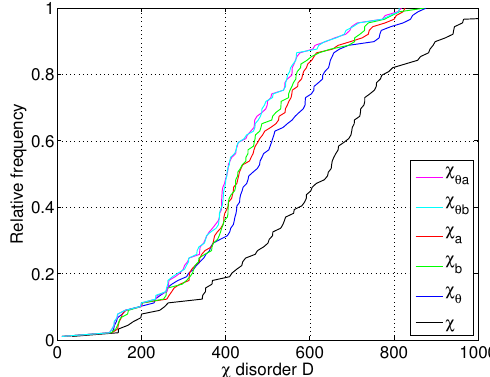
Figure 3. Cumulative distribution of the χ disorder for the 89 con- sidered catchments in Taiwan for 0 . 01 km 2 ≤ A ≤ 100 km 2 . Each curve describes the relative number of the catchments with a χ dis- order lower than or equal to the value D on the x